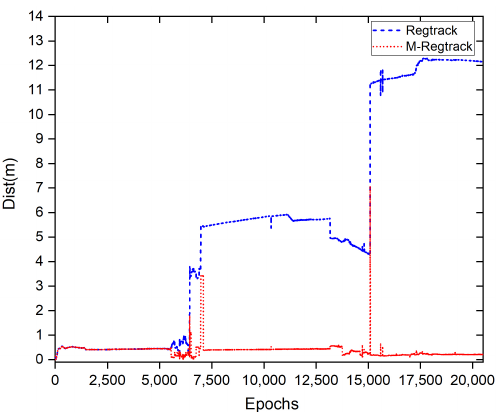
Figure 10. The trajectory tracking error result of different methods referenced to the solution of the LAMBDA method, where Dist =